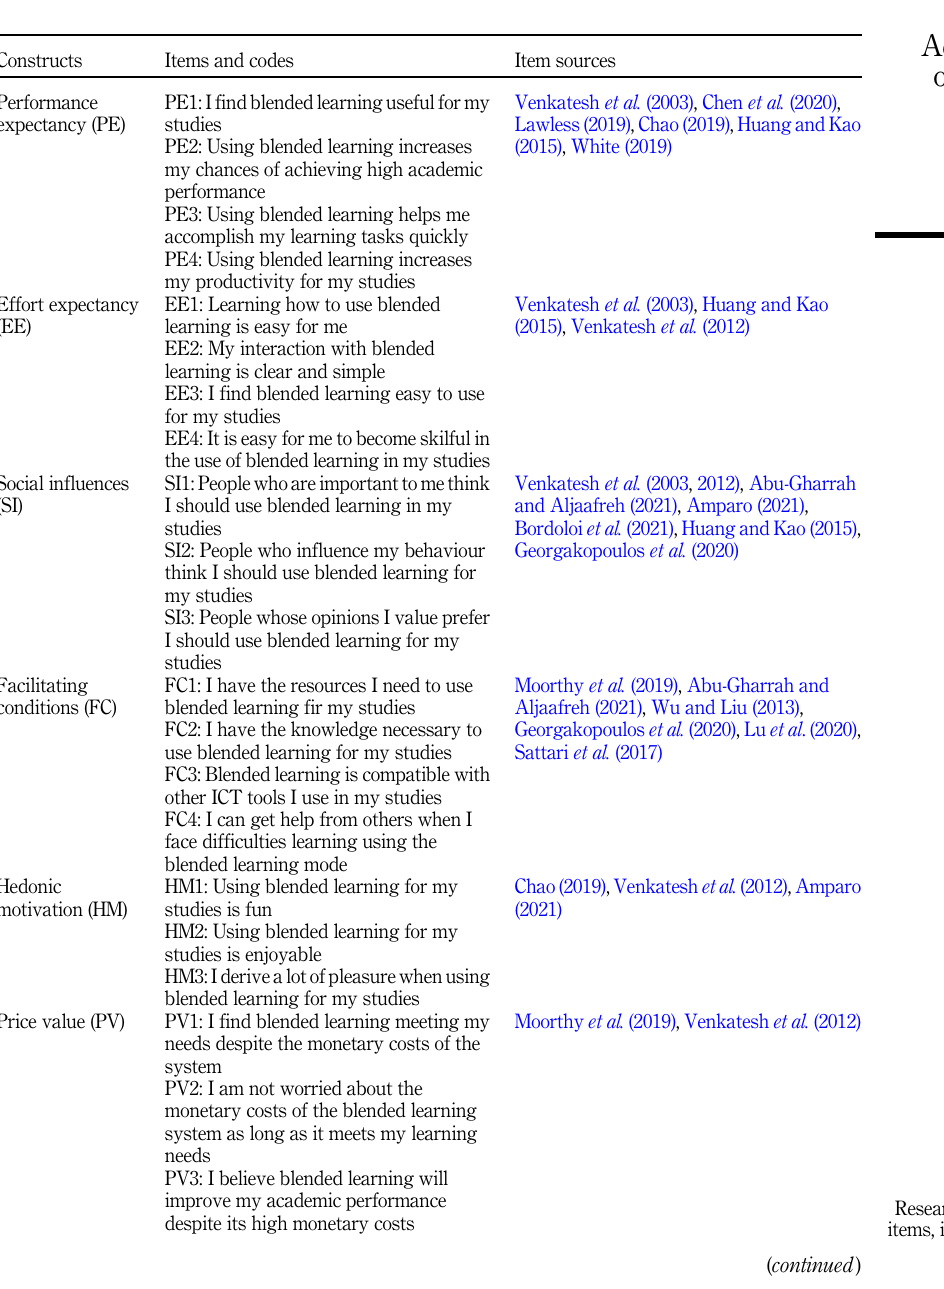
Table 2. Research constructs, items, item codes and